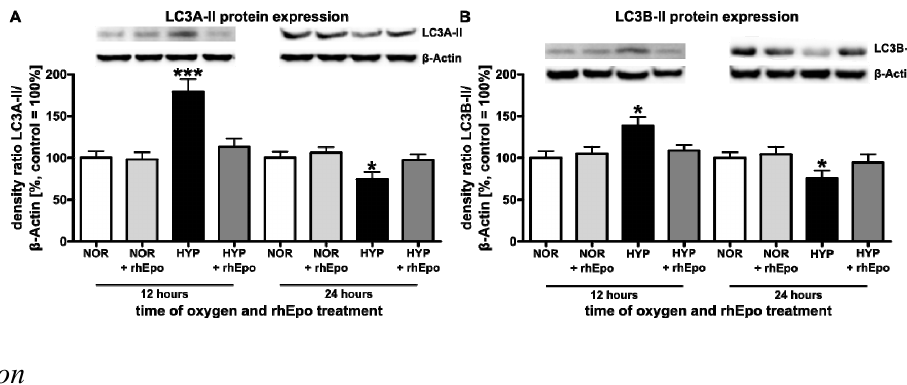
Figure 3. Erythropoietin restores hyperoxia–mediated changes of LC3A-II and LC3B-II in the developing brain. ( A , B ) LC3A-II and LC3B-II protein expression, the densitometric data represent the ratio of the pixel intensity of the LC3A-II or LC3B-II band to the corresponding β -actin band. White bar normoxic control (NOR); light grey bar normoxic control + rhEpo; black bar hyperoxia (HYP); dark grey bar hyperoxia + rhEpo. Data are normalized to levels of rat pups exposed to normoxia (control 100%; bars represent mean + SEM, n = 8 per group, *** p < 0.001, * p < 0.05, independent t -test